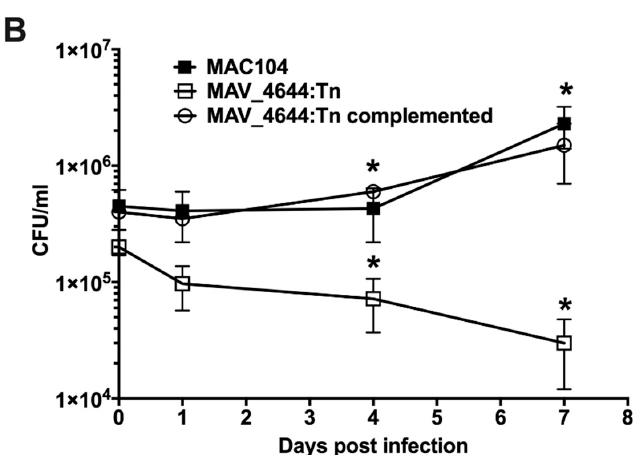
Figure 3. Inactivation of MAV_4644 gene. ( A ) Comparison of in vitro growth of wild-type MAC104, MAV_4644 gene knockout and complemented strain in the aerated 7H9 medium supplemented with OADC. ( B ) Survival of MAC104 (black squares), MAV_4644:Tn (open squares) and MAV_4644:Tn complemented clone (open circles) in murine macrophages. RAW264.7 cells were cultured in DMEM supplemented with 10% FBS in 24-well plates and infected with either the wild-type MAC104 or MAV_4644:Tn mutant for 2 h at 37 ◦ C and 5% CO 2 . The cells were washed twice with HBSS and incubated for an additional 2 h in culture medium supplemented 200 µ g / mL of gentamicin. Monolayers were washed and supplemented with 10 ng / mL of murine IFN- γ in DMEM. At reported time points, macrophages were lysed with 0.1% Triton X-100, serially diluted, plated on 7H10 agar plates and incubated at 37 ◦ C for 8–10 days before colonies were counted for CFU. Survival results of the wild-type and complemented strain versus mutant were analyzed using Student’s t test. *, p < 0.05 was determined significant. Table 2. Conserved domain analysis of MAV_4644 protein.